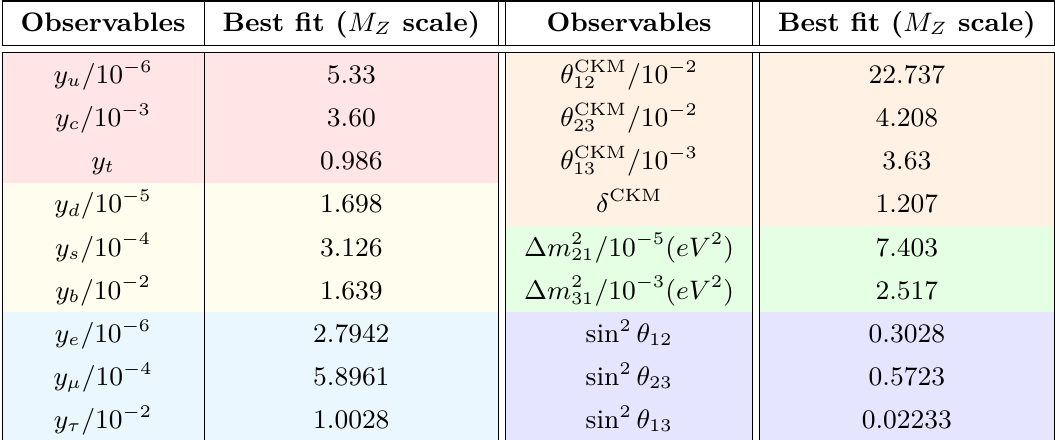
Table 4 . Best fit values of the observables by restricting the intermediate symmetry breaking scale. In particular, we fix M 3 = 4 × 10 13 GeV that results in χ 2 = 0 . 52 , hence representing an excellent agreement with measurements. See text for details.